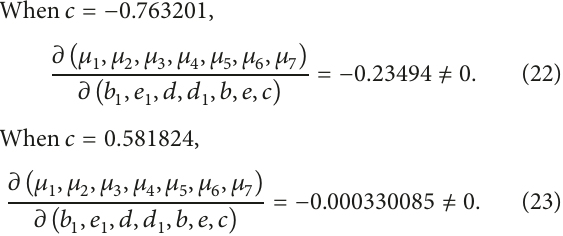
When 𝑐 = −0.763201